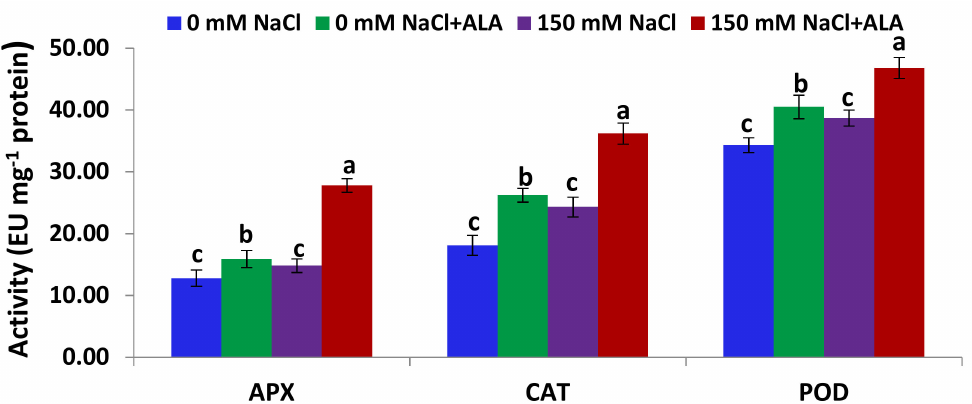
Figure 4. Activities of ascorbate peroxidase (APX), catalase (CAT), and peroxidase (POD) in the leaves of the Nain Ordinaire cultivar following salinity (150 mM NaCl) and 5-aminolevulinic acid ([ALA], 6 ppm) treatments. Data are means ± standard error (SE) ( n = 4). Different letters indicate significant differences between treatments ( p ≤ 0.05).